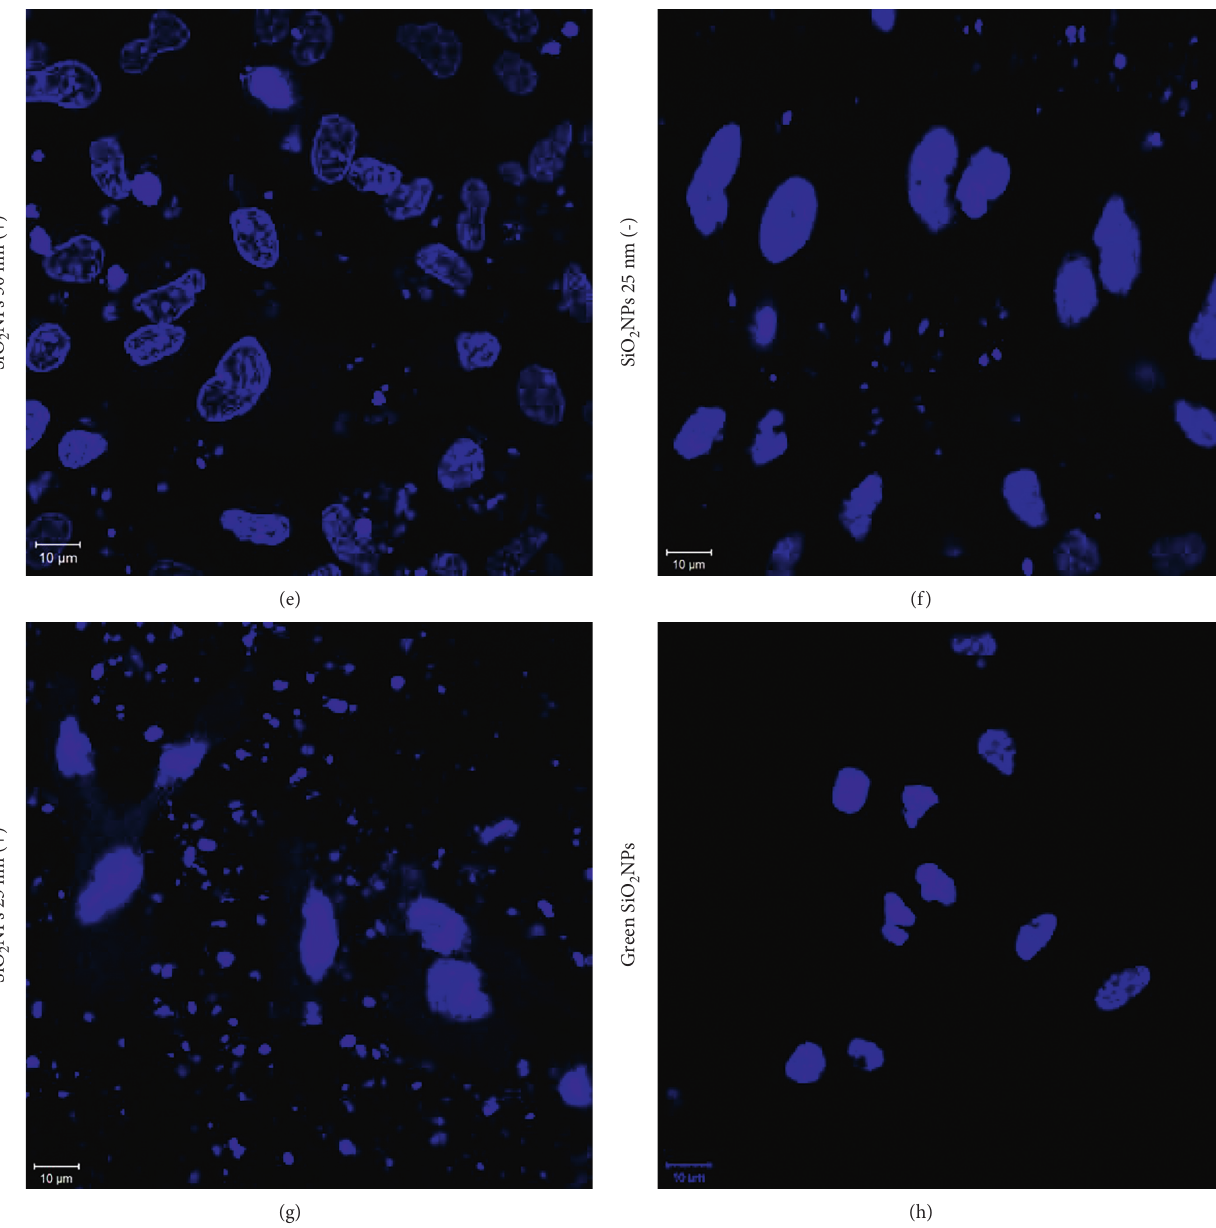
Figure 9: Representative confocal images of untreated A549 cells (a) and cells exposed to 5mg/mL of SiO 110nm (+) (c), SiO 2 NPs 50nm ( − ) (d), SiO 2 NPs 50nm (+) (e), SiO 2 NPs 25nm ( − ) (f), SiO 2 NPs 25nm (+) (g), and green SiO 2 NPs (h) on A549 nuclei after 48h. The cells were fixed and then stained with DAPI. Images were acquired using a Zeiss LSM700 (Zeiss) confocal microscope, equipped with an Axio Observer Z1 (Zeiss) inverted microscope, using a × 100, 1.46 numerical aperture oil immersion lens. All data were processed using the ZEN